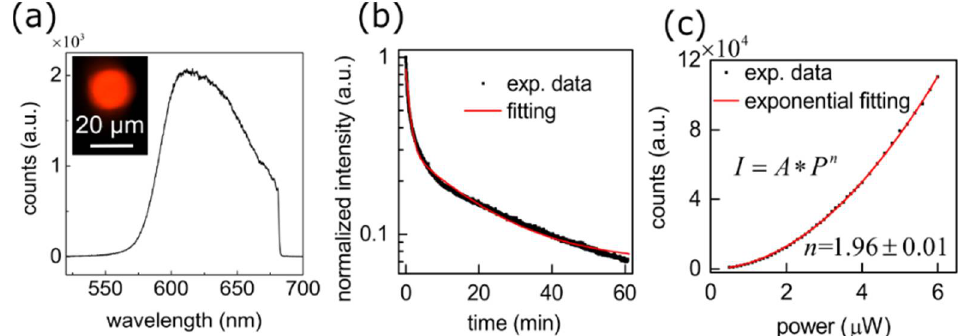
Figure 7. Fluorescence data from MEH-PPV microspheres. ( a ) Two-photon fluorescence spectrum from a single microsphere. The inset shows an epifluorescence image captured by a color camera. ( b ) The normalized fluorescence intensity of a single microsphere as a function of time at an excitation power of 2 mW. The red curve represents a double exponential fitting. ( c ) Two-photon fluorescence intensity as a function of the incident laser power. The red curve shows a power law fit which yielded an exponent of 1.96 ± 0.01.